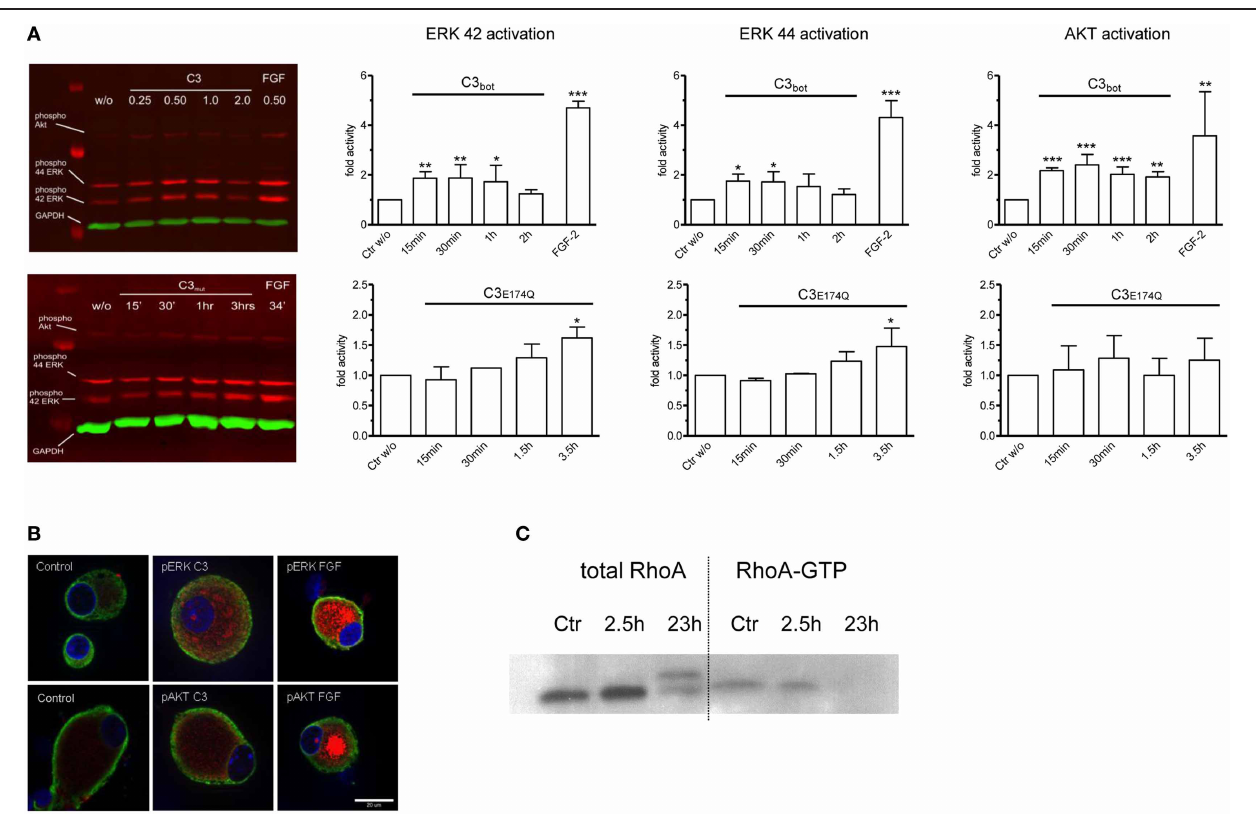
∗∗ p < 0 . 01, ∗∗∗ p < 0 . 005). Immunofluorescence labeling of pERK and pAkt (red) in control DRG neurons and in neurons treated with C3 bot or FGF-2 ( B ; 1 μ g/ml for 30min; tubulin in green and Hoechst staining in blue). Note that treatment with C3 bot for 2.5h does not reduce RhoA-GTP loading suggesting a RhoA-independent activation of ERK and Akt (C)